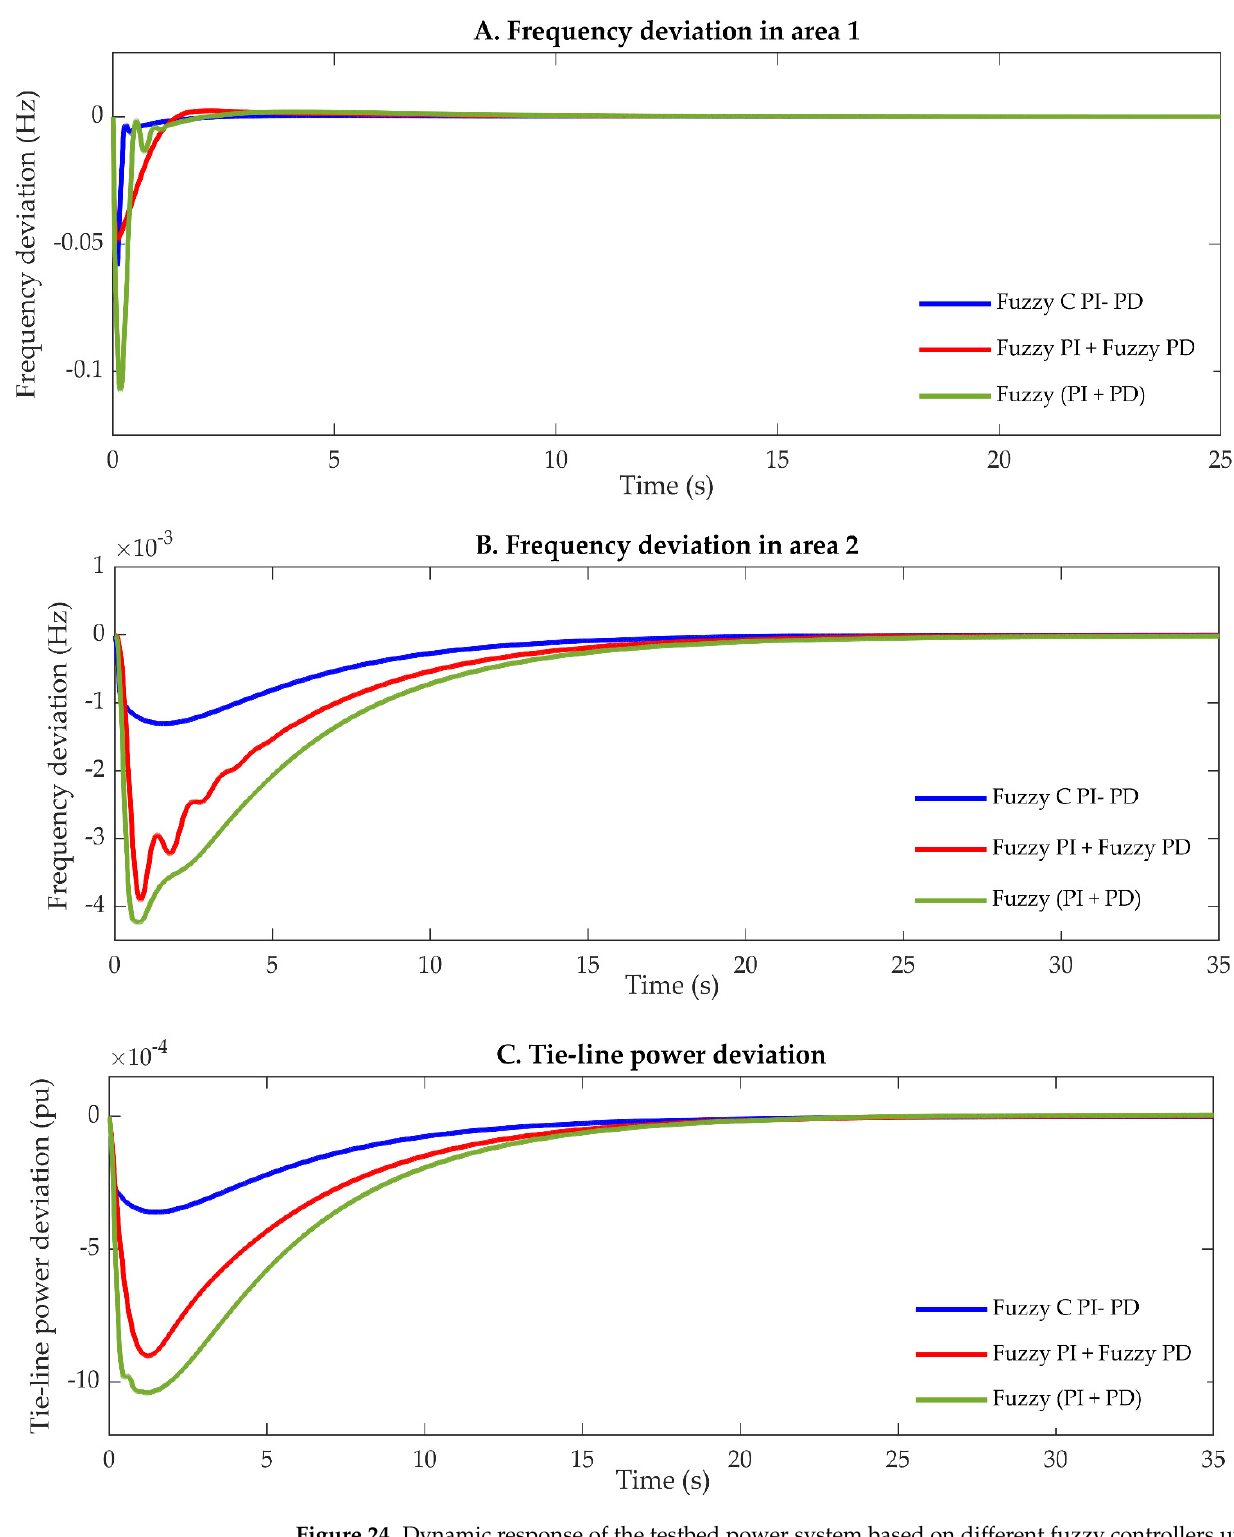
Figure 24. Dynamic response of the testbed power system based on different fuzzy controllers under parametric uncertainty conditions, case 3. ( A ) Frequency variation in area 1; ( B ) frequency variation in area 2; ( C ) tie-line power variation.